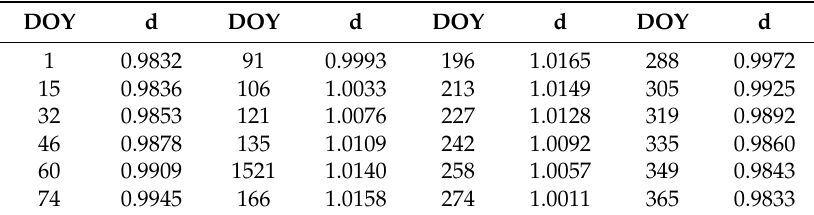
Table 3. The Earth-Sun distance in astronomical